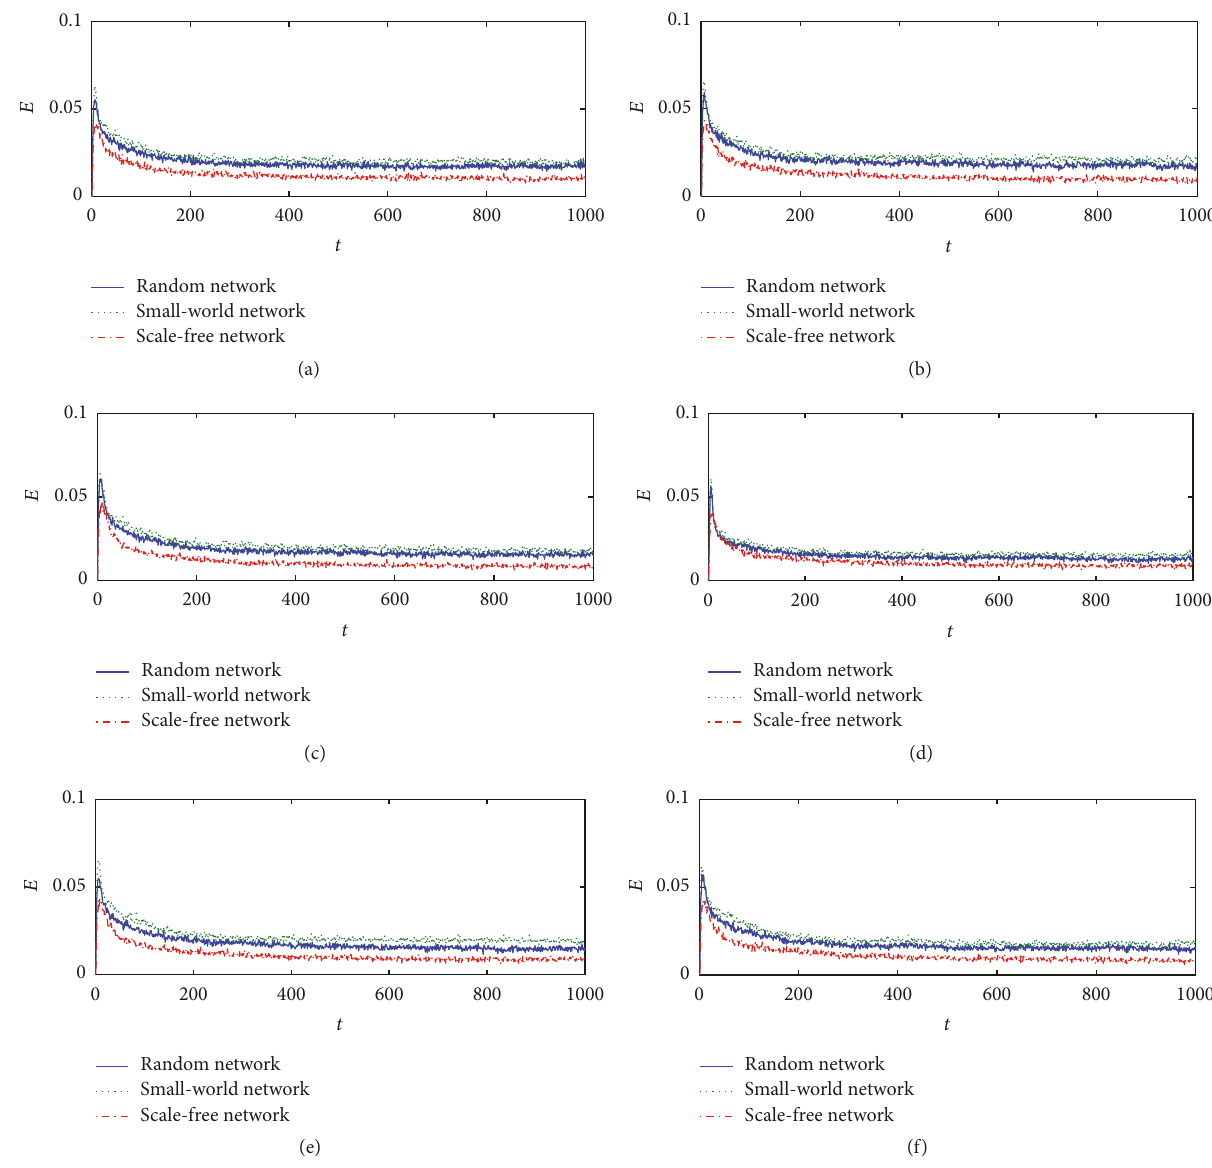
Figure 3: Network entropies in the three kinds of interbank networks under different parameter values. (a)–(f) are the results when 𝛾 𝑘 = 0.2 , = 0.3 , 𝑀 = 0.06 , 𝑀 = 0.1 , 𝜏 = 2 , and 𝜏 = 3 , 𝛾 𝑘 𝑘 𝑘